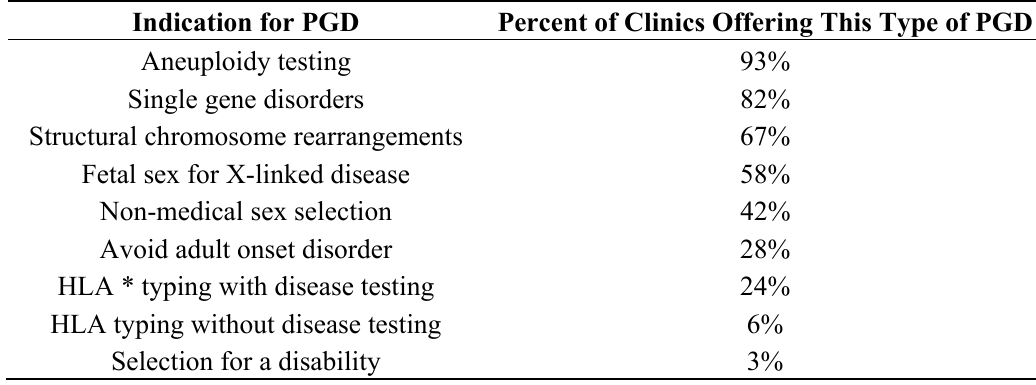
Table 2. Results of a survey of 137 in vitro fertilization (IVF) centers regarding the indications for which PGD was offered in their clinic. PGD for aneuploidy testing, genetic disorders and structural chromosome rearrangements was performed by the majority of the respondents